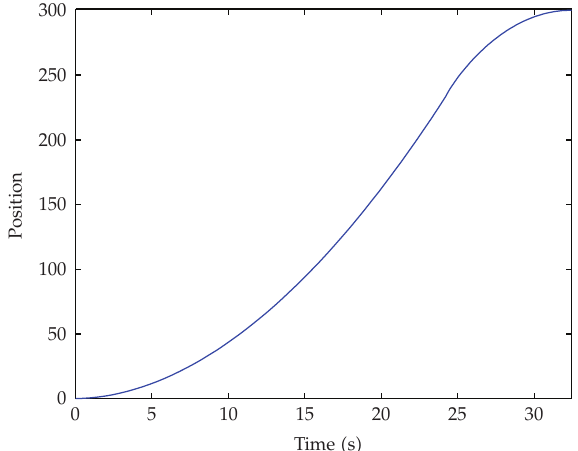
Figure 2: States x (cid:5) t (cid:6) as functions of time t for the Bang-Bang control problem for α (cid:7) 0 . 9.